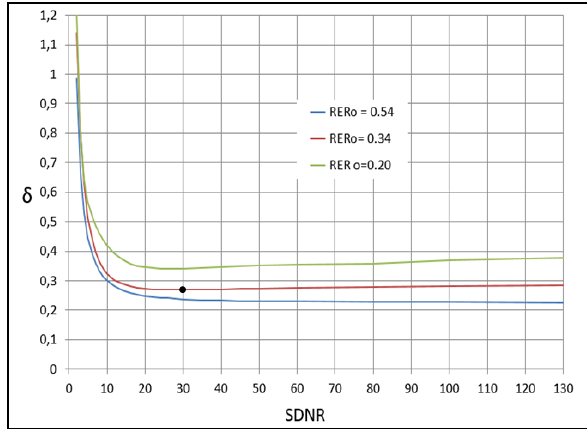
Figure 7: NIIRS error of GIQE 4C for reference